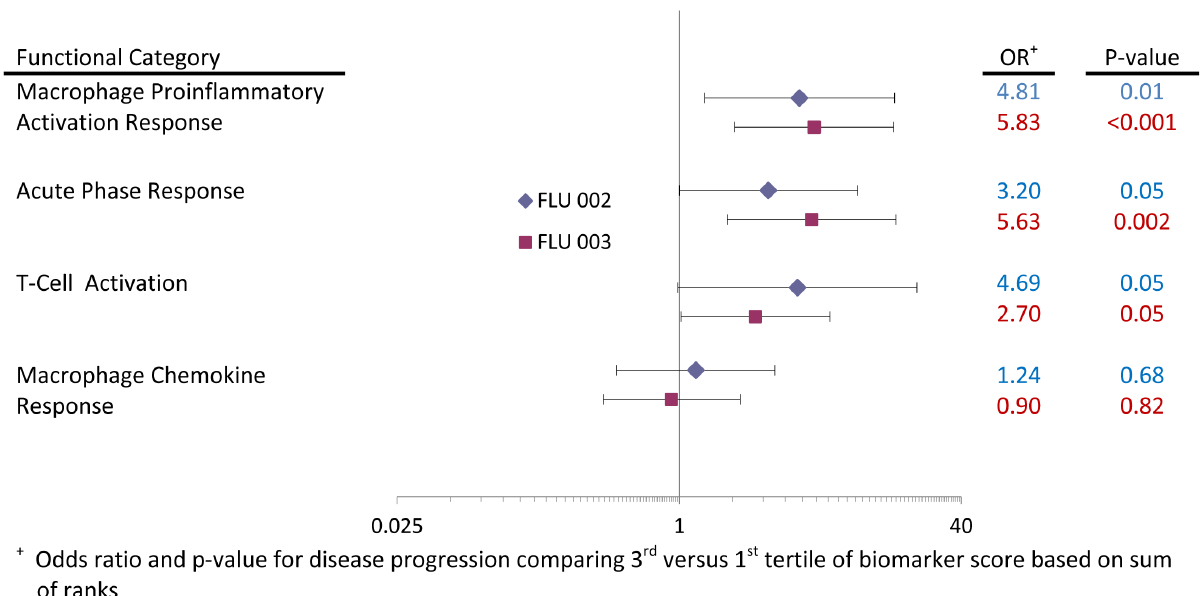
Figure 4. Relationship of functional categories of biomarkers to disease progression in FLU 002 and FLU 003. The odds ratios and 95% confidence intervals for the risk of disease progression in FLU 002 (in blue) and FLU 003 (in red) are depicted according to four functional categorizations of the 25 biomarkers analyzed in these two studies.